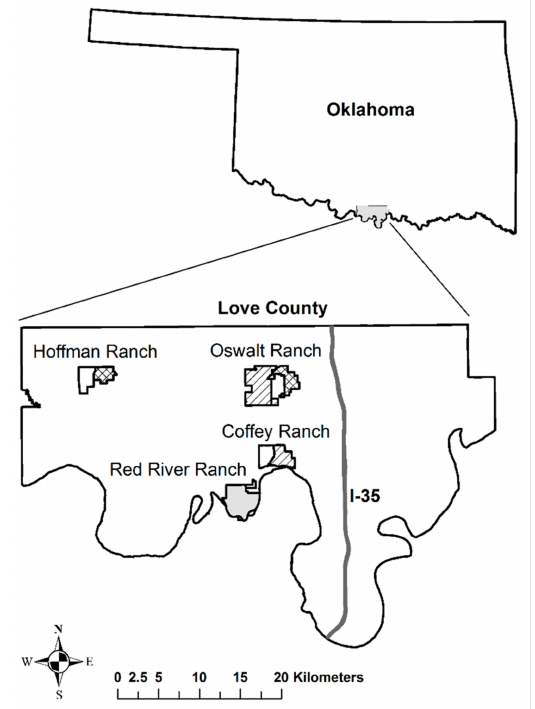
Figure 1. Study area map depicting the Noble Research Institute Oswalt Road Ranch (ORR; 2027.9 ha), Noble Research Institute Coffey Ranch (CR; 1010.6 ha), Noble Research Institute Red River Ranch (RRR; 1316 ha; experiment 2 [solid gray polygon]), and the Hoffmann Ranch (HR; 945.2 ha) located in Love County, Oklahoma. Experiment 1 study sites (ORR, CR and HR) were divided into two units, resulting in six total units where control (i.e., no harvest [open, hollow polygon]) and trapping (i.e., corral traps [crosshatch pattern] and drop nets [dashed lines]) were assigned at random; two units were assigned to each respective treatment and control. Corral traps (east unit; 592.2 ha) and drop nets (west unit; 1435.7 ha) were installed on ORR, drop nets (east unit; 579.7 ha) and a no harvest control (west unit; 431.5 ha) at CR, and corral traps (east unit; 415.8 ha) and a no harvest control (west unit; 529.4 ha) at HR. During Experiment 2, suspended traps were deployed across ORR, CR and RRR in 2012 to determine efficacy and